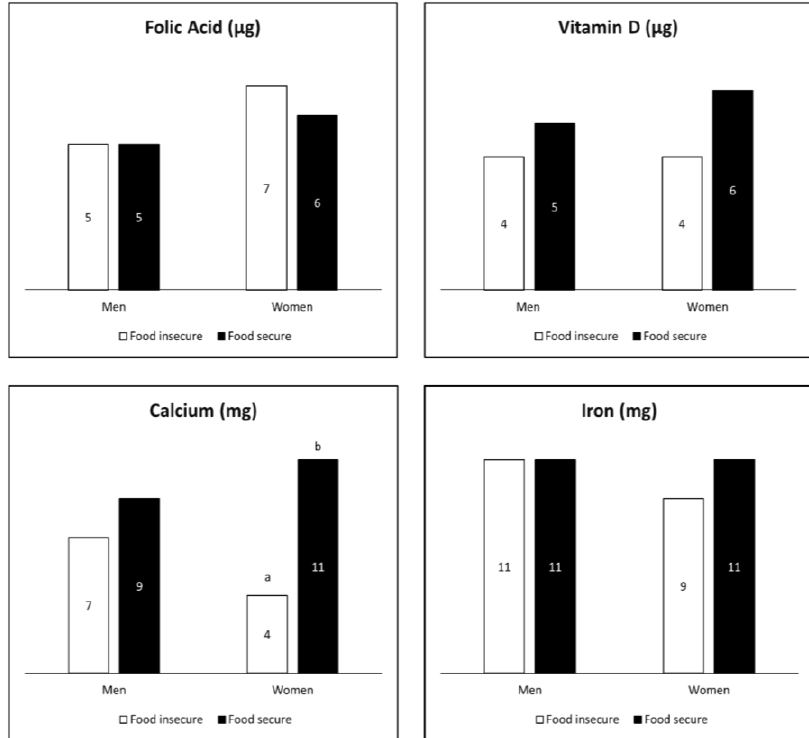
Figure 2. Estimated percent (%) of total micronutrient intakes above the Tolerable Upper Intake Level (UL) by food security status among adult ( ≥ 19 years) supplement users in the U.S., 2011–2014. 1,2 ( 1 The analytic sample includes individuals ≥ 19 years old that were not pregnant or lactating with complete information for food security and the day 1 and 2, 24 h dietary recalls. Numerical data labels within each bar represent the estimated proportion (%) of U.S. adult supplement users with intakes greater than the UL. 2 Di ff erent superscript letters denote a significant di ff erence between food security categories within sex at a p -value < 0.0125 . ).